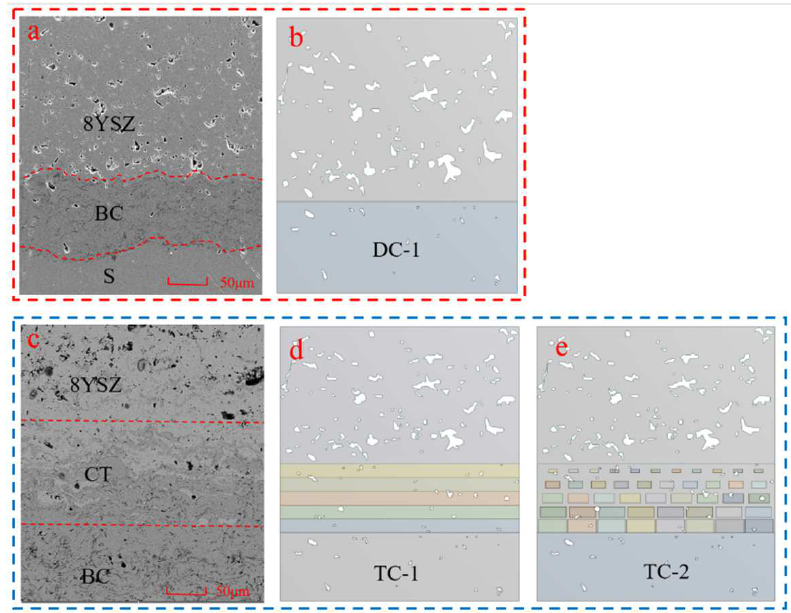
Figure 7. SEM image of traditional coating ( a ) and continuous transition coating ( c ), models with pores in traditional coating ( b ) and continuous transition coating ( d , e ).